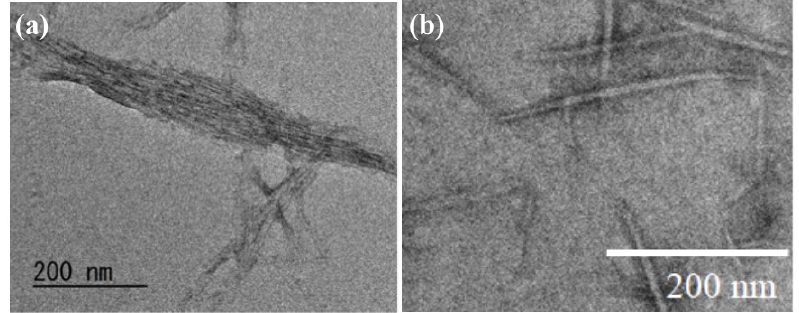
Figure 5. TEM images of: ( a ) self-assembled ChNFs; and ( b ) SD-ChNFs. The self-assembled ChNFs were also formed by gelation of chitin with the choline chloride-thiourea DES system (10% w / w ), followed by dilution with water [53]. Further- more, a paper-like chitin sheet comprising longer ChNFs, named ‘chitin paper’, was fabri- cated via regeneration from the solution of chitin in DES of 1-allyl-3-methylimidazolium/ thiourea [54]. The chitin paper exhibited better mechanical properties than the abovemen- tioned self-assembled ChNF